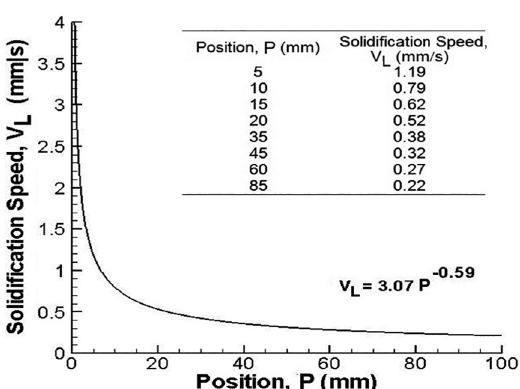
) versus position ( P ) along the L